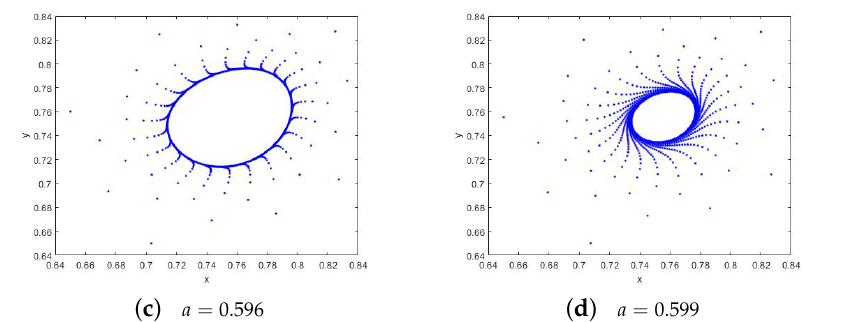
Figure 3. Phase portraits for system (10) with b = 1.4 and different a when the initial value ( x 0 , y 0 ) = ( 0.05,0.05 ) is outside the closed orbit.